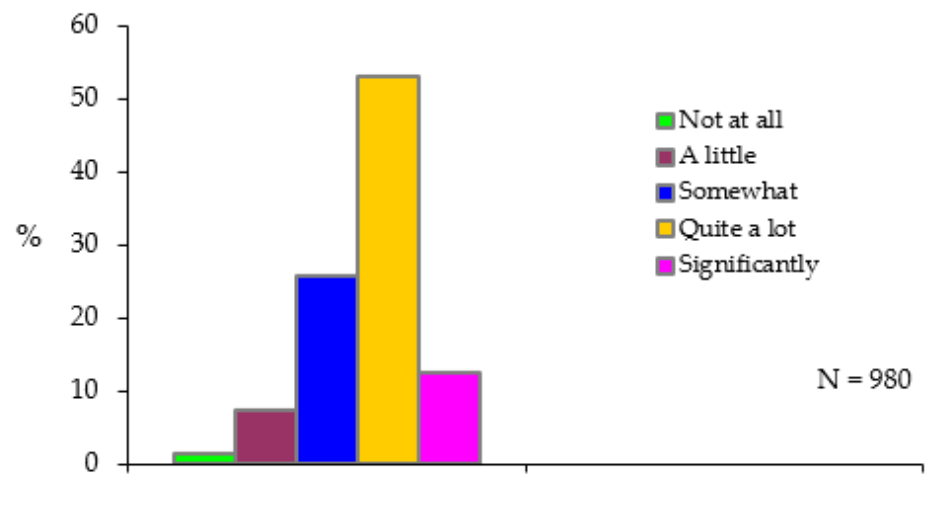
Figure 7. ‘Control of life’ frequencies.